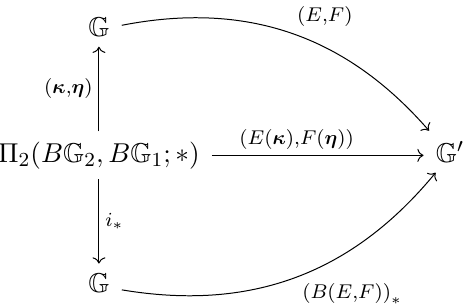
Figure 25 . The upper triangle commutes by definition of the configuration ( E ( κ ) , F ( η )) , while the lower triangle commutes by construction of the map B ( E, F ) .